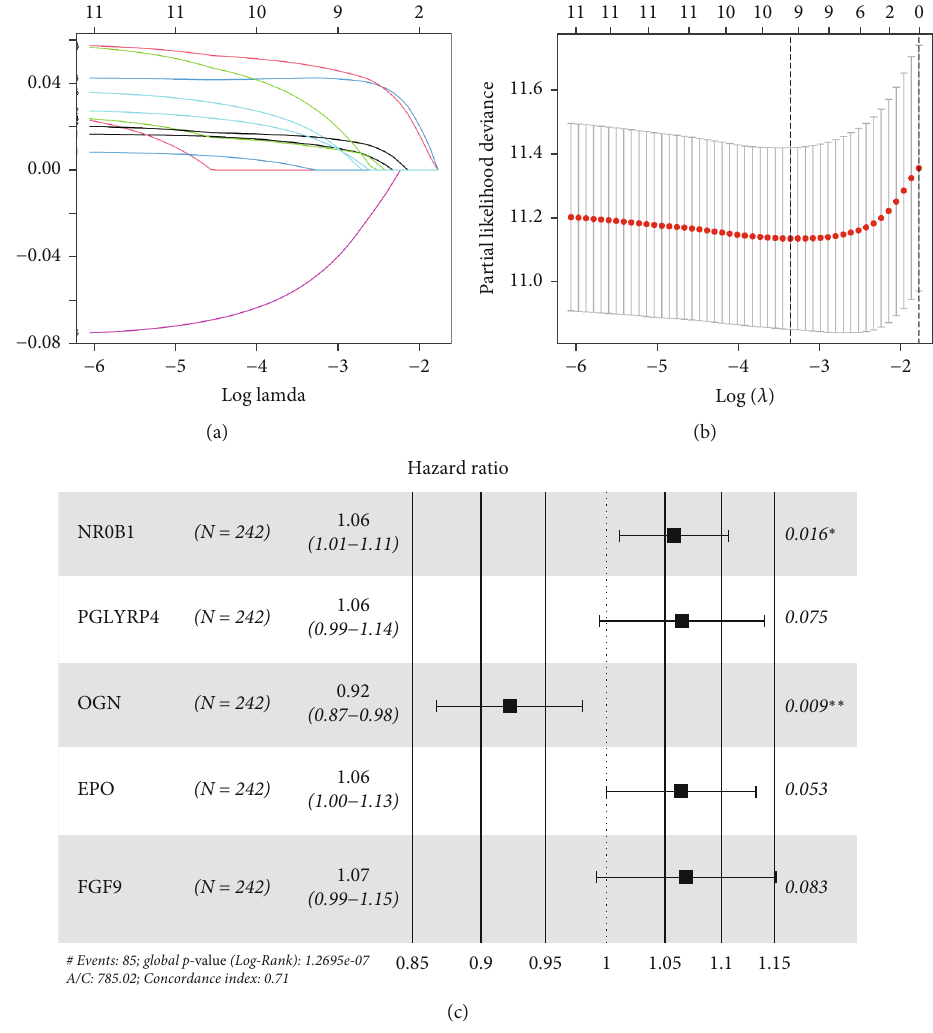
Figure 3: Immunological pro fi le prognostic model construction. (a) The coe ffi cients of the 12 prognostication-related IRGs in the lasso analysis change trajectory with the penalty function lambda. (b) The selection interval of the optimal penalty parameter, and the upper coordinate represents the number of genes at di ff erent lambda values. (c) Forest plot of multivariate Cox analysis of fi ve prognosis- related IRGs ( ∗ P < 0 : 05 , ∗ P < 0 : 01